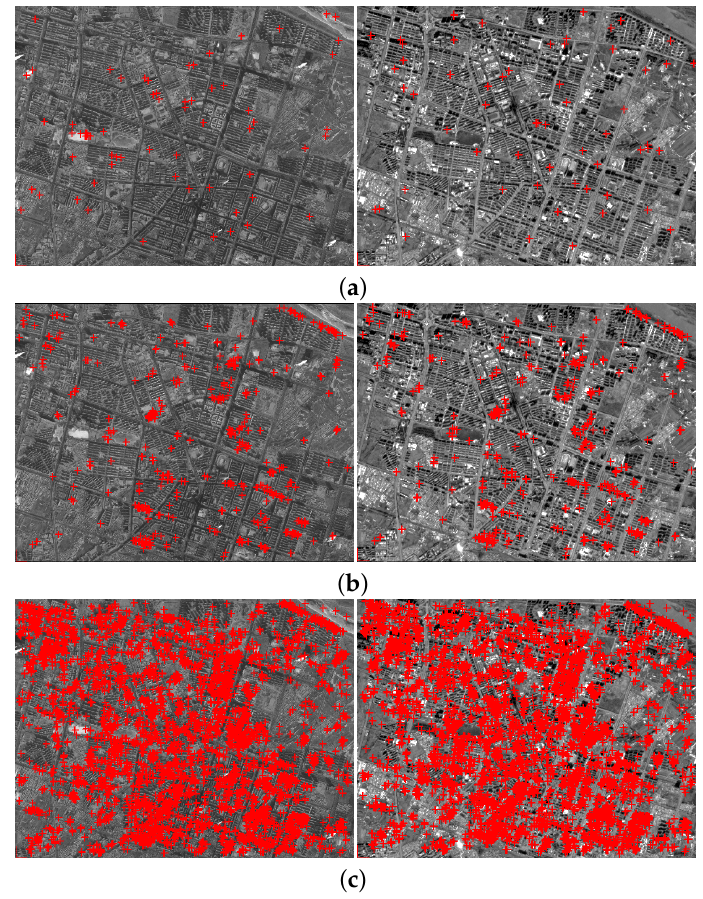
Figure 14. Comparison of the matching results produced by the three methods: ( a ) the matching result produced by TAACC; ( b ) the matching result produced by GC 3 ; ( c ) the matching result produced by the proposed method.